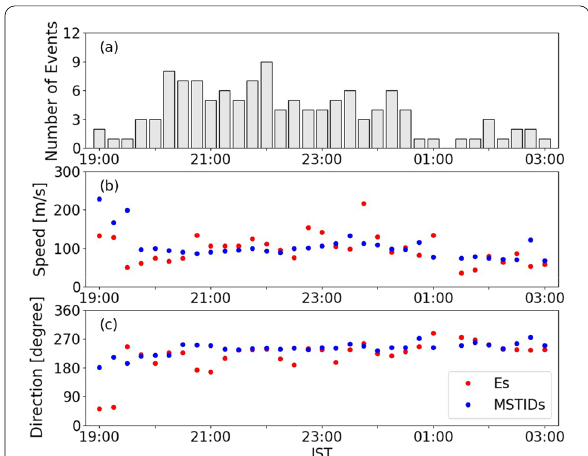
Fig. 7 a LT variation of the number of events. b LT variation of the averaged propagation speed. c LT variation of the averaged propagation directions. In the panel b and c , red circles indicate the parameters of Es and blue circles do